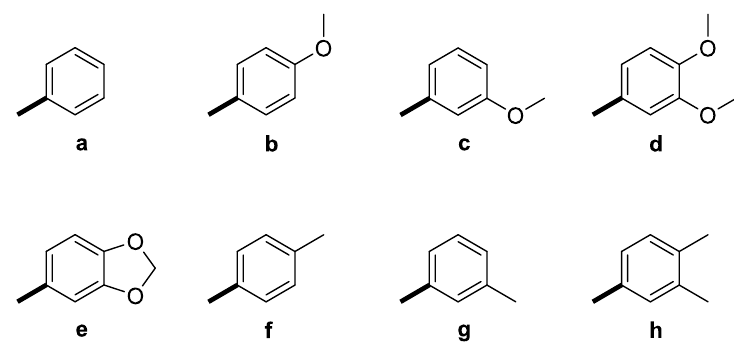
Figure 2. Aromatic substituents (Ar) used in the designed GAL-CU hybrid molecules.